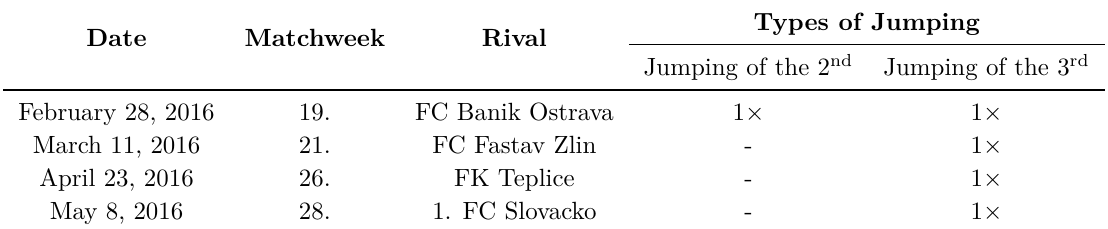
Table 2. Table of occurrence of synchronized jumping crowd during the match – SK Slavie Praha.